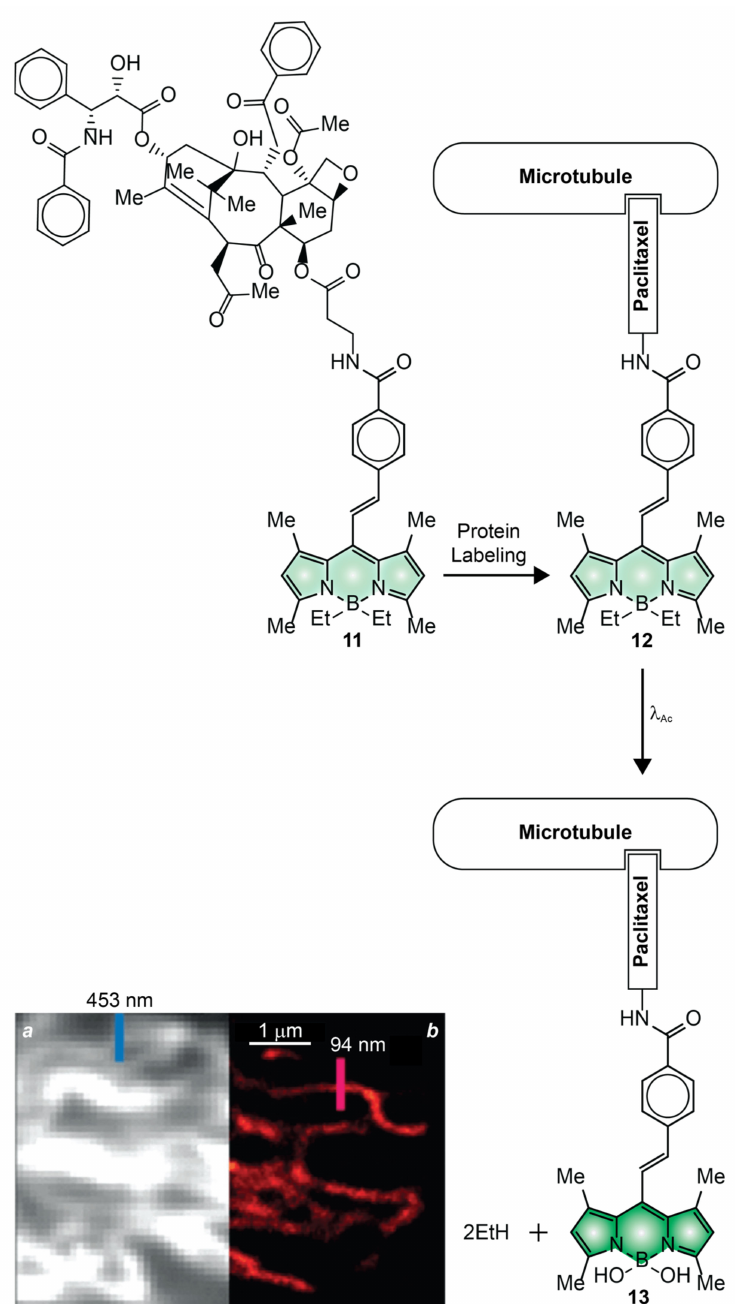
Figure 9. Diffraction-limited ( a ) and PALM ( b ) images of live HeLa cells, stained with 11 , reporting the full width at half maximum of emission-intensity profiles (blue and red bars) measured across the labeled microtubules [adapted with permission from Ref.